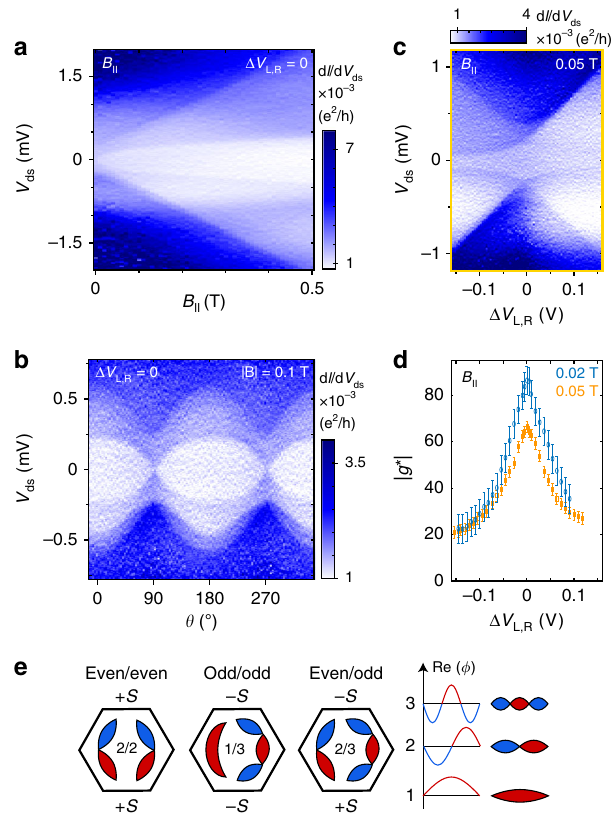
Fig. 5 3e regime and requirements for ring formation. a Measurement of d I /d V ds versus V ds and B || at zero detuning. The SOI breaks e-h symmetry, leading to an increasing GS-ES gap with B || for all three excited states in the 3e regime. b Measurement of d I /d V ds as a function of B - fi eld direction for |B| = 0.1 T at zero detuning. c Measurement of d I /d V ds when detuning the orbitals along the yellow gate vector (c.f. Fig. 1f) for B || = 0.05 T. d Experimental values of | g *| for the GS-ES1 transition based on a linear approximation. In the case of B || = 0.02 T (blue), the extracted | g *| corresponds to | g 2 *|, while we fi nd a reduced value at B || = 0.05 T (orange) due to the avoided orbital crossing near this B || - fi eld. The error bars represent the uncertainty in energy gap extraction due to measurement noise and resolution. e Schematic representation of the real part of the wave functions (Re( Φ )) in crossings of even/even (2/2), odd/odd (1/1), and even/odd (2/3) orbitals. The blue and red colour correspond to negative and positive Re( Φ ). Nearly perfect rings can only be observed in the case of even/odd combinations where the overlap integral ( S ) has different sign at the two connection